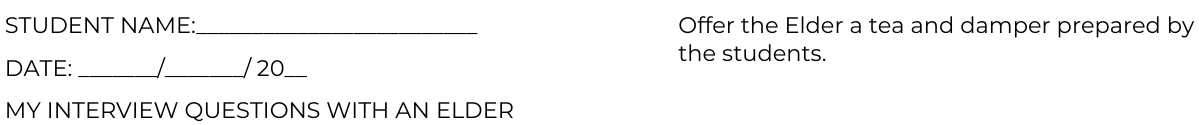
Table 1: Students’ Interview Protocol with Elders: Collecting Animal